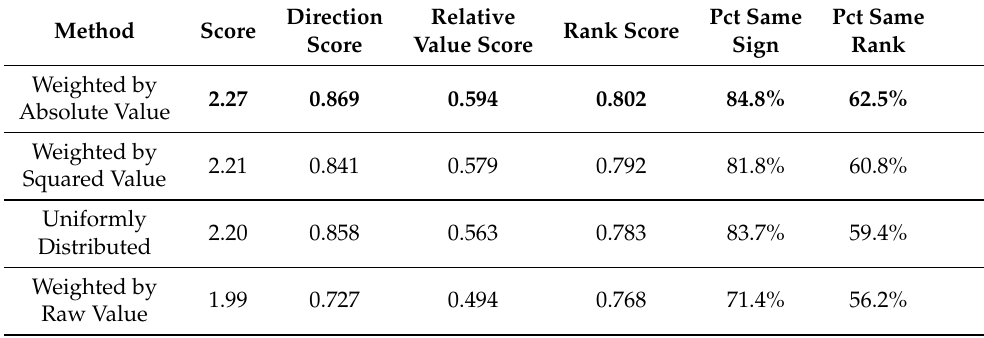
Table 2. Results of the simulation for different methods of distributing α , note that the highest score in each column is indicated with boldface